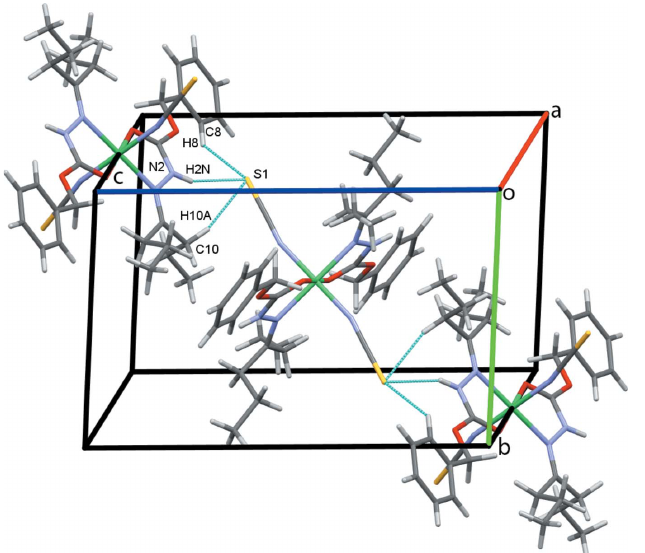
Figure 2 Chains of molecules of 1 along the bc diagonal. Hydrogen bonds are drawn as dashed cyan lines.